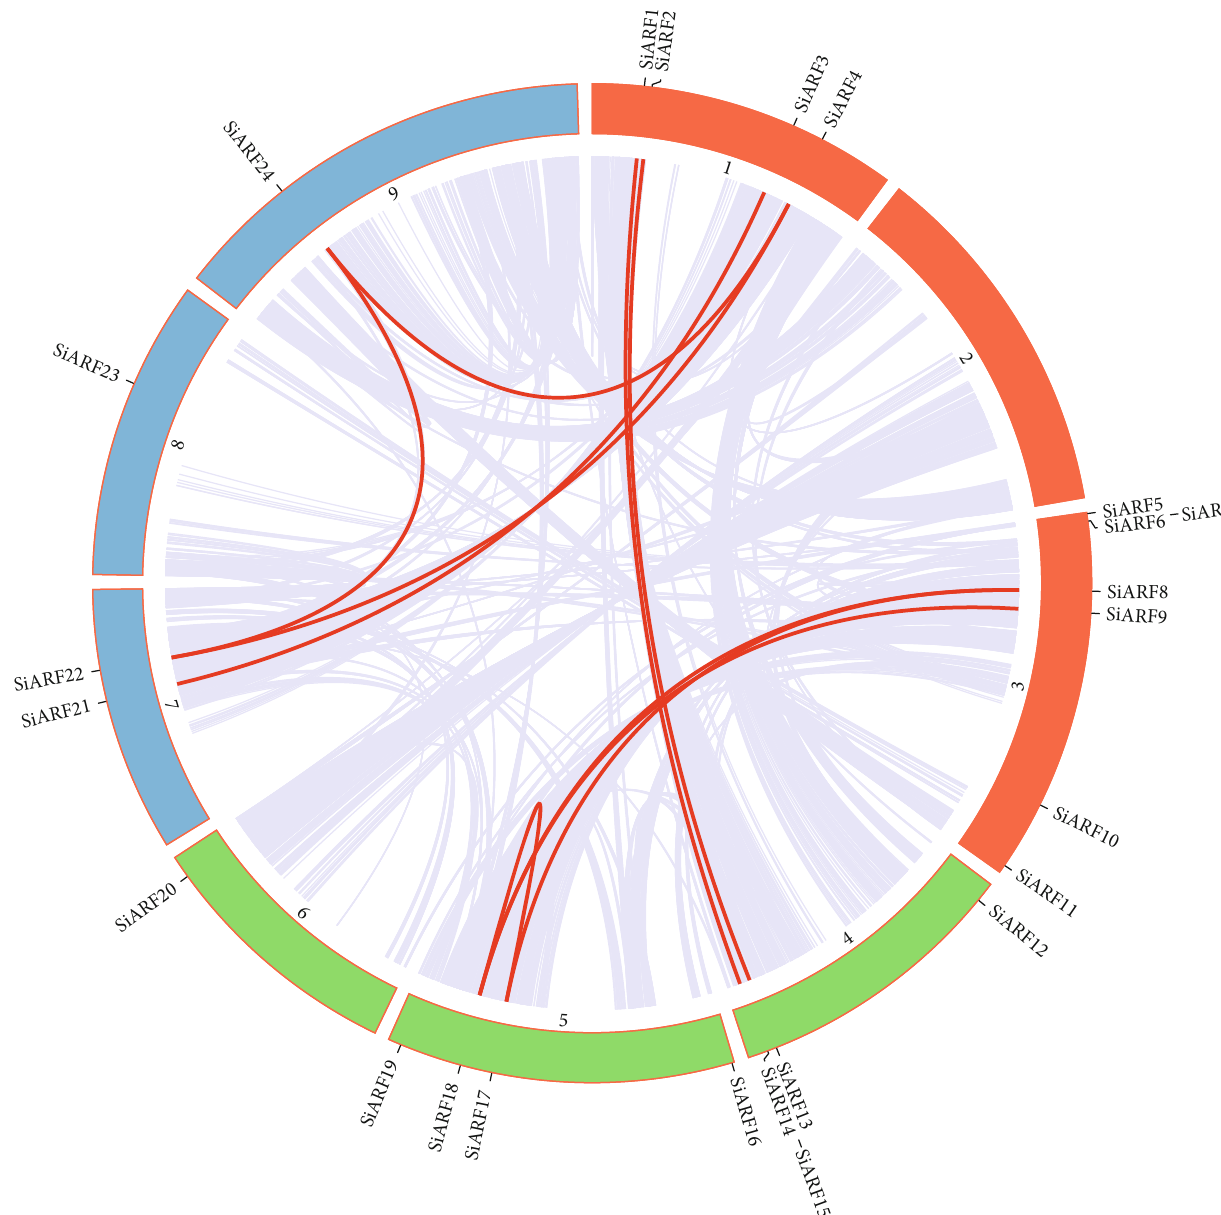
Figure 2: Collinear analysis of SiARF genes. Genome-wide collinear genes in Setaria italica were marked with grey lines. SiARF whole- genome duplication gene pairs were emphasized by red